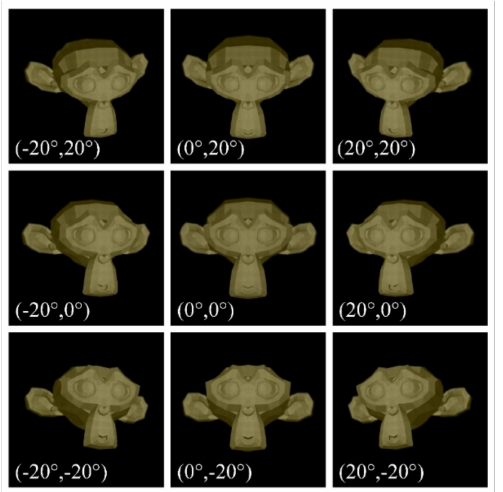
Figure 11. Simulation results of the reconstructed monkey head captured from 3 × 3